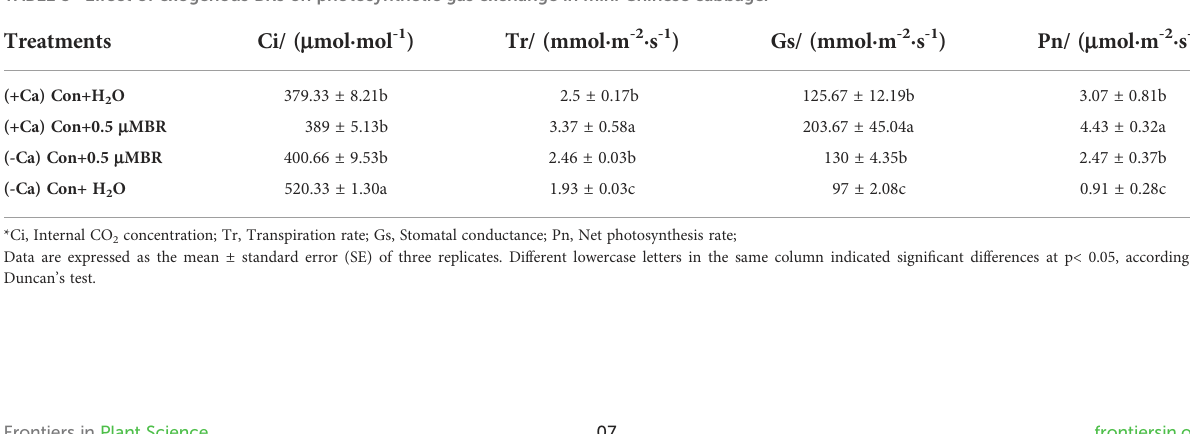
TABLE 3 Effect of exogenous BRs on photosynthetic gas exchange in mini Chinese cabbage.